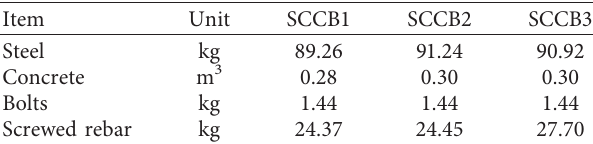
Table 5: Quantity survey of SCCBs.